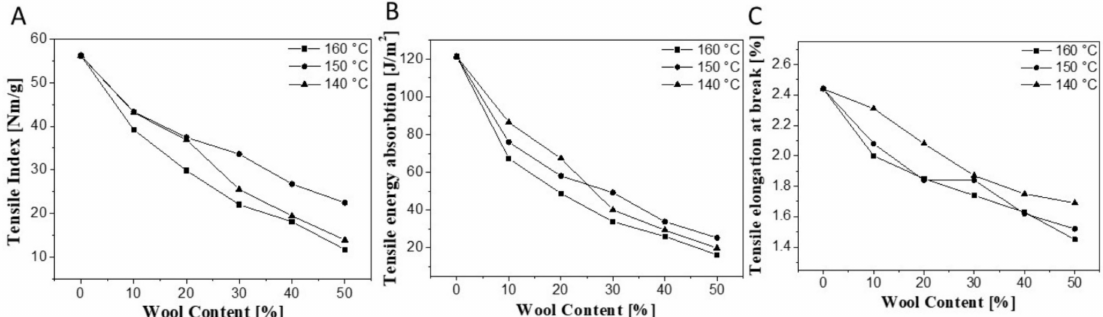
Figure 6. Tensile index ( A ), tensile energy absorption ( B ), and elongation at break ( C ) of 100% kraft cellulose pulp biocomposite (0% wool content) and kraft cellulose pulp/hydrolyzed wool at different hydrolyzed temperatures with 10–50% of wool content in